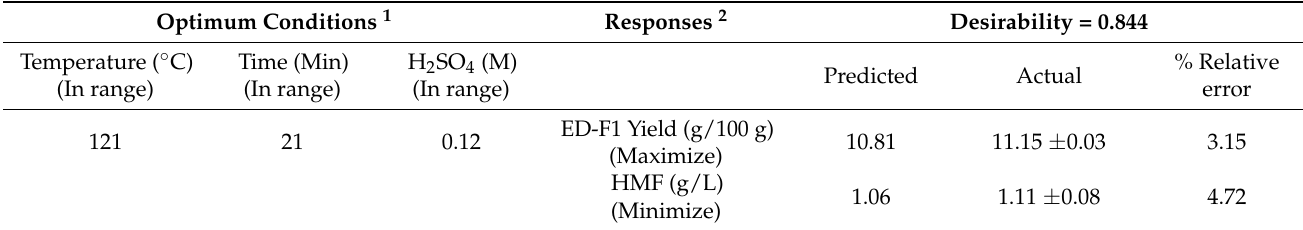
Table 3. Validation of conditions for the optimum yield of ED-F1.